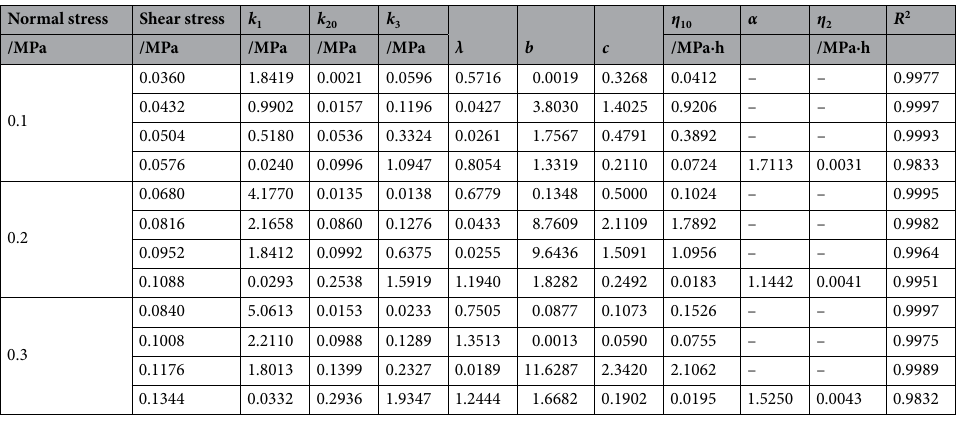
Table 3. Model parameter identification